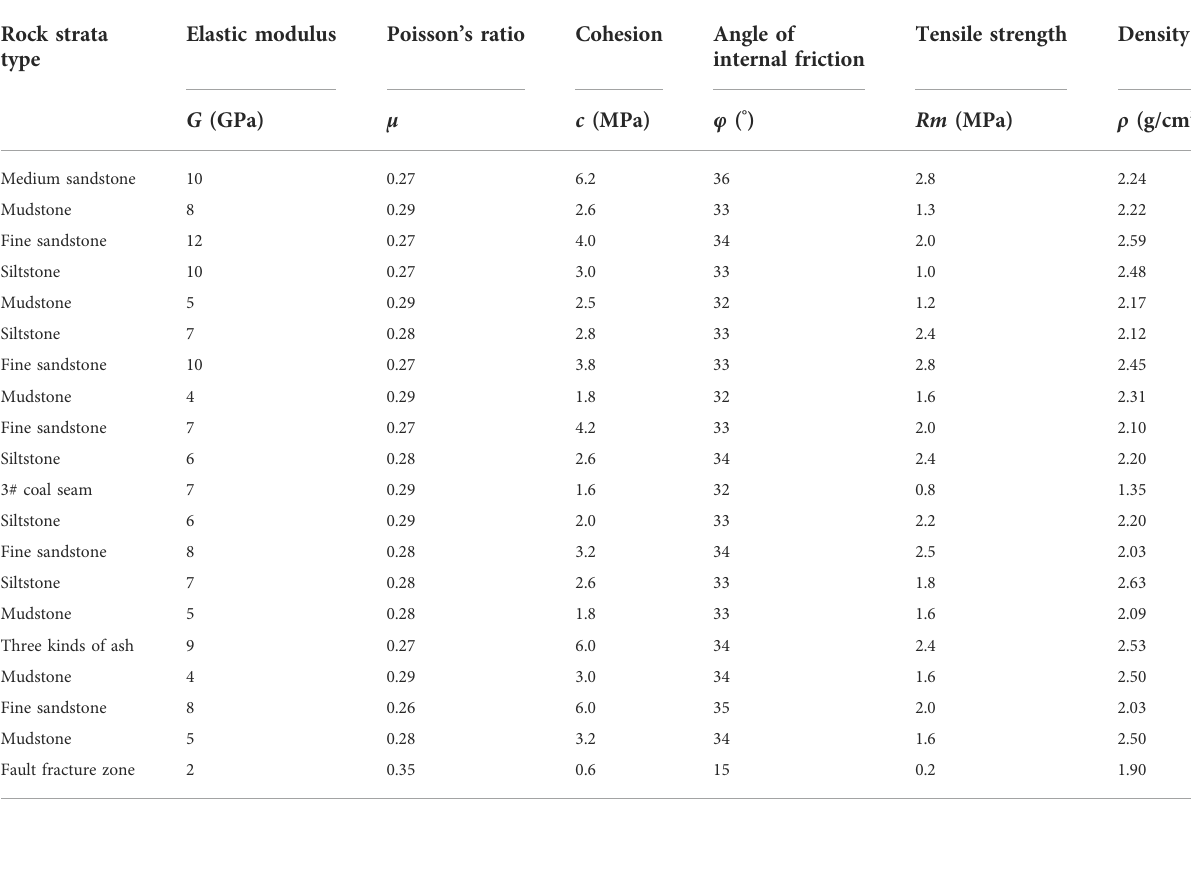
TABLE 8 Geomechanical parameters of coal and rock formations.